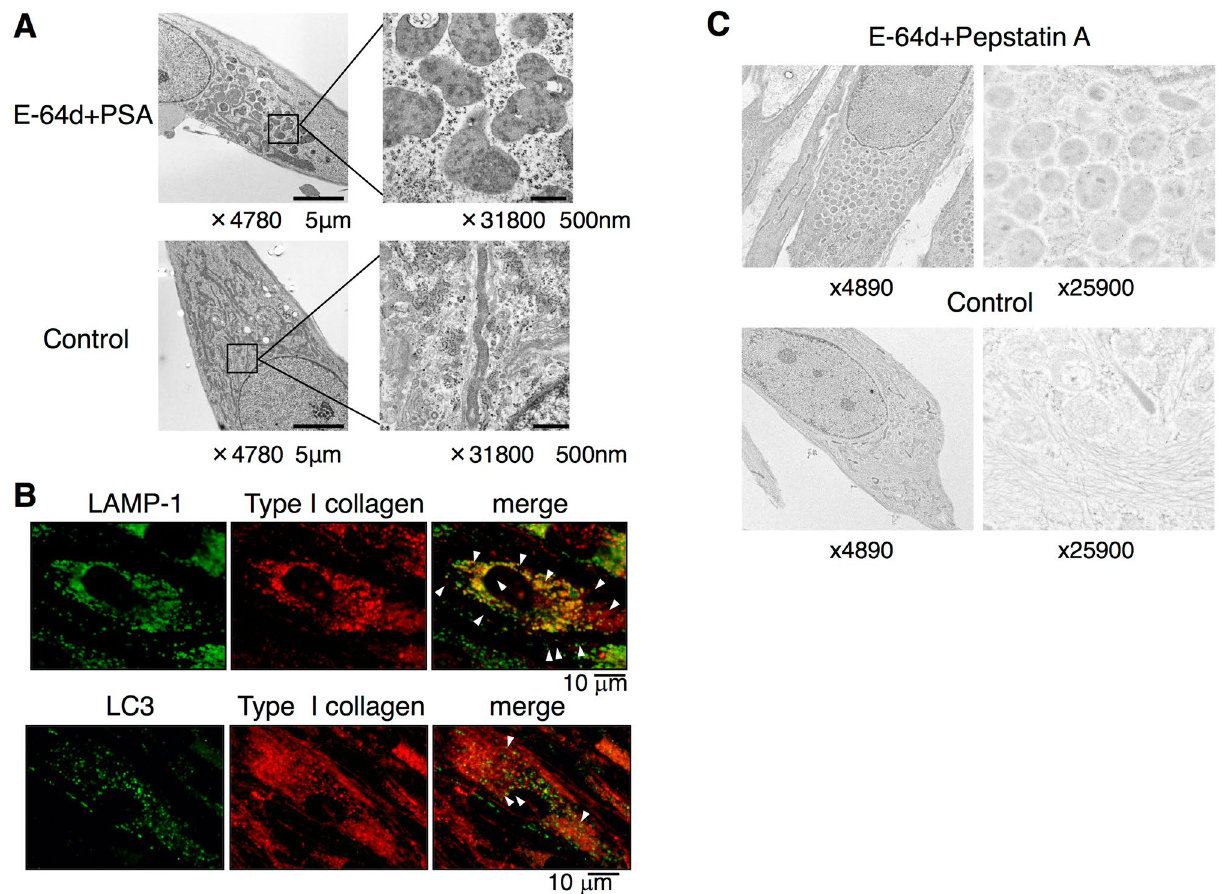
Figure 5. Transmission electron microscopy indicates the accumulation of collagen I in the autophagosome in human periodontal ligament (HPDL) cells. ( A ) Transmission electron microscopy showed the induction of the enlarged autophagosome in the presence of autophagy inhibitors, E-64d plus pepstatin A (10 µg/ml) after treatment with no-serum Hank’s balanced saline solution (HBSS) for 4 days. Magnified image of the bold square in was showed in right panels (× 30,600). AP; Autophagosome AL; Autolysosome. ( B ) Immunofluorescence staining for the collagen I and LAMP-1 showed the accumulation of collagen after the ossification inducing culture for 6 days in the presence of autophagy inhibitors, E-64d plus pepstatin A (10 µg/ml). White square indicates the colocalisation of collagen I and LAMP-1 positive dots. Representative data from three independent experiments are shown. ( C ) Immune electron microscopy of autophagosome in aged HPDL cells showed the collagen I in enlarged autophagosomes following immune-gold labelling for type I collagen. HPDL cells were treated in the presence of autophagy inhibitors, E-64d plus pepstatin A (10 µg/ml) for 4